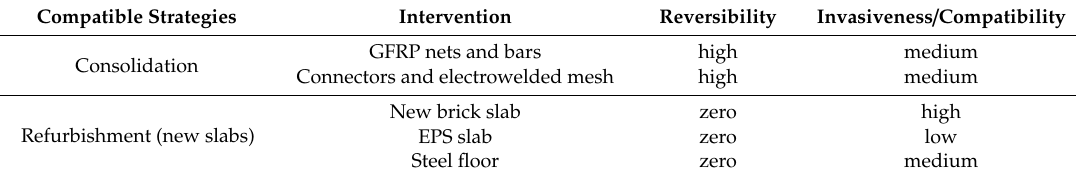
Table 2. Summary of the structural interventions studied for the slab.